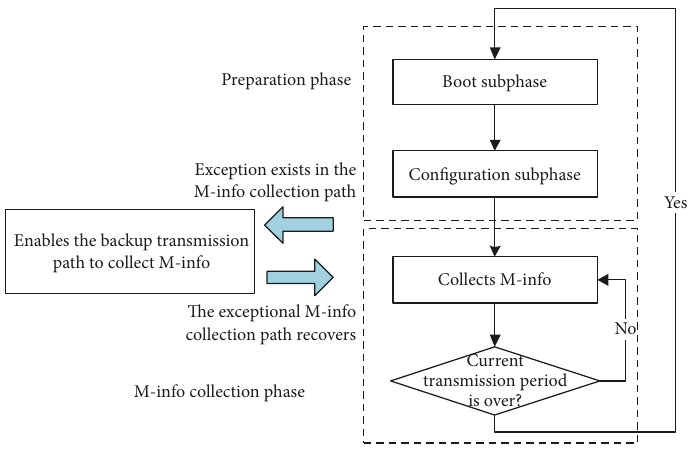
Figure 3: Overview of the